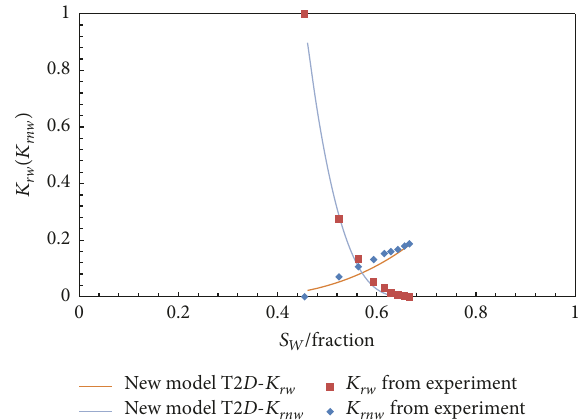
Figure 9: Nonwetting phase’s relative permeability of Sample 5 calculated by